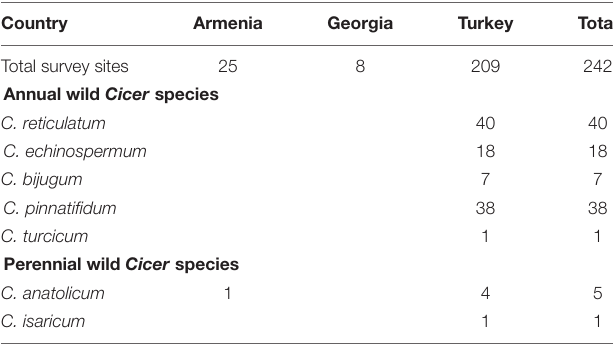
TABLE 3 | Number of survey sites in which wild Cicer species were found, categorized by country and